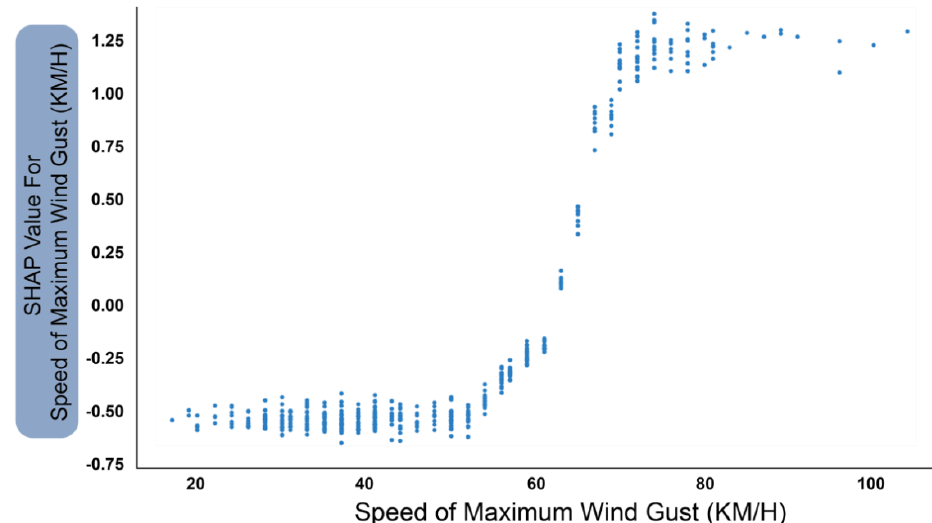
Figure 11. SHAP explanation of dependence plot for speed of max wind gust.